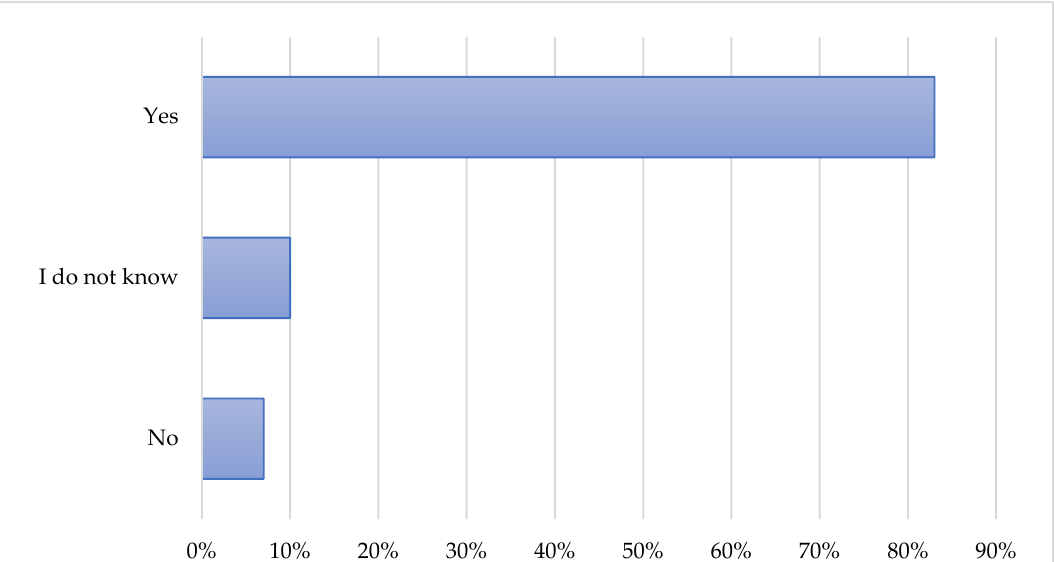
Figure 3. Percentage of farmers who affirm or deny that agrochemicals are a health risk.